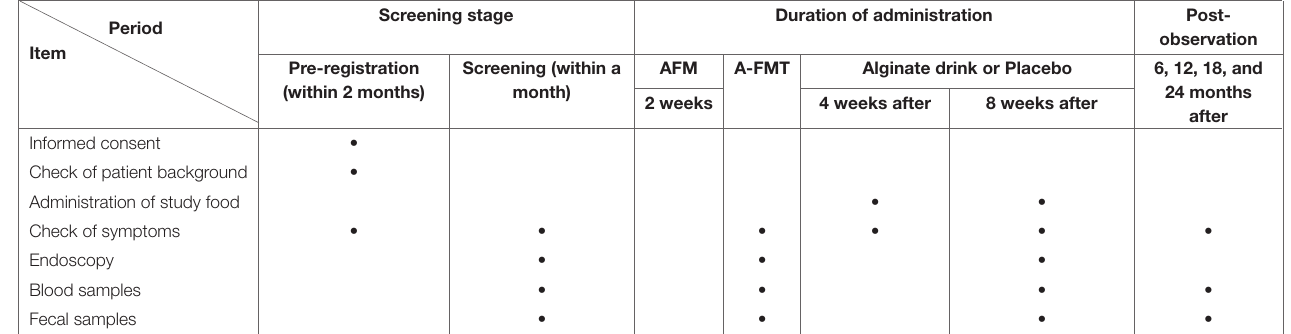
TABLE 3 | Protocol for sequential therapy of A-FMT with alginate drink or placebo.